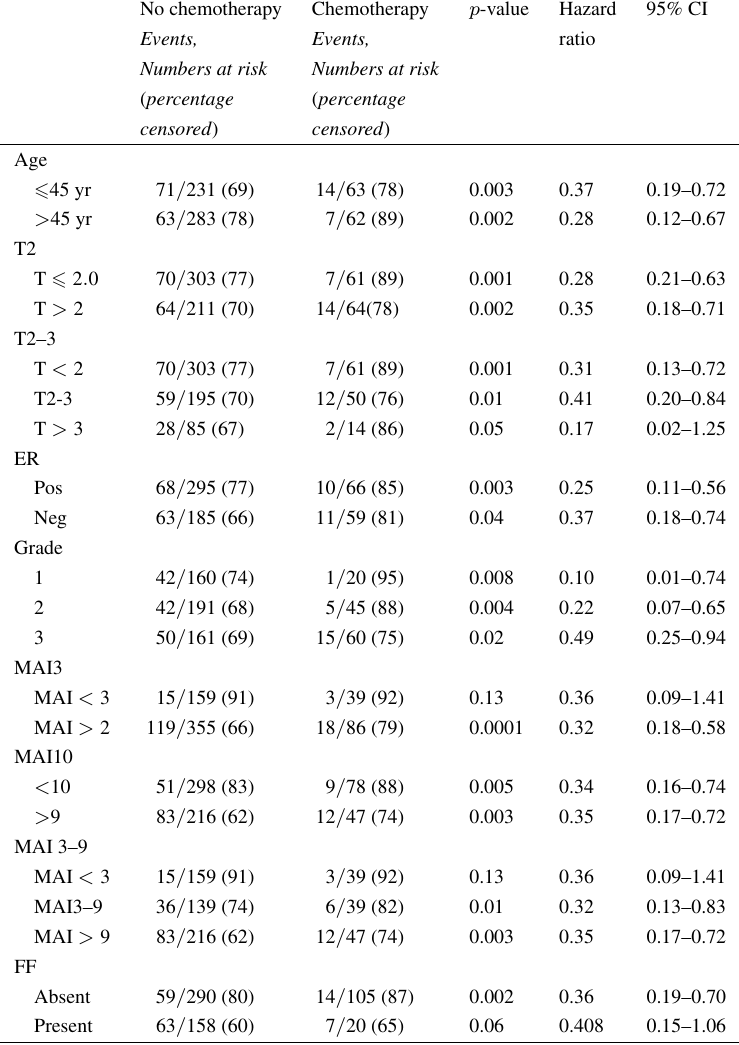
Recurrence Free Survival in the total population of 639 lymph node-negative patients under 55 years, divided in no chemotherapy vs chemotherapy. For the MAI, only the most significant thresholds are